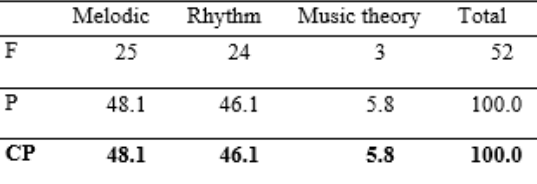
Table 6. Student’s attitudes about